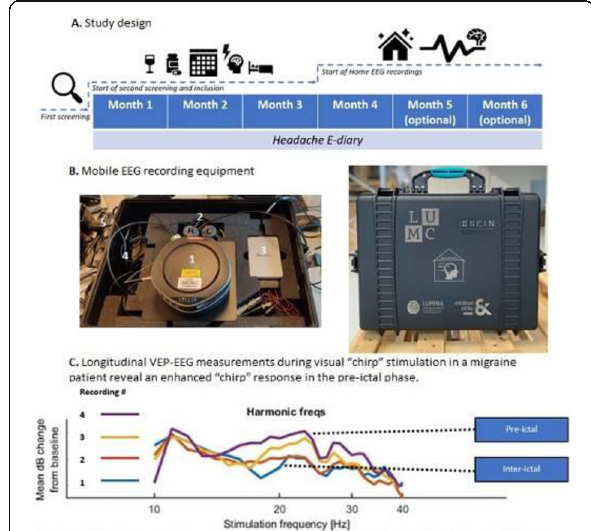
Fig. 1 (abstract P93). A Study design 1B. Suitcase for mobile EEG equipment for recordings at patient ’ s home containing: 1) EEG device 2) LED goggles 3) Triggerbox 4) Headcaps in different sizes 5) Power supply. 1C. Unpublished data of migraine patient